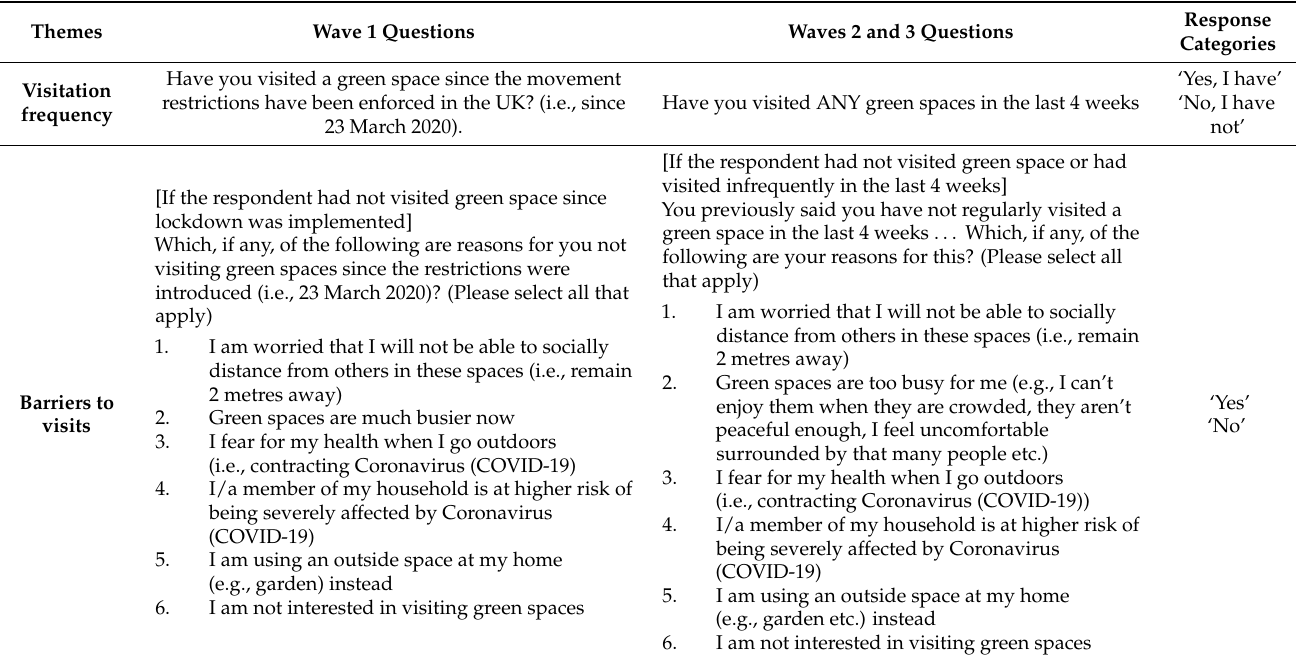
Table 1. The survey themes, question wording (by wave), and response